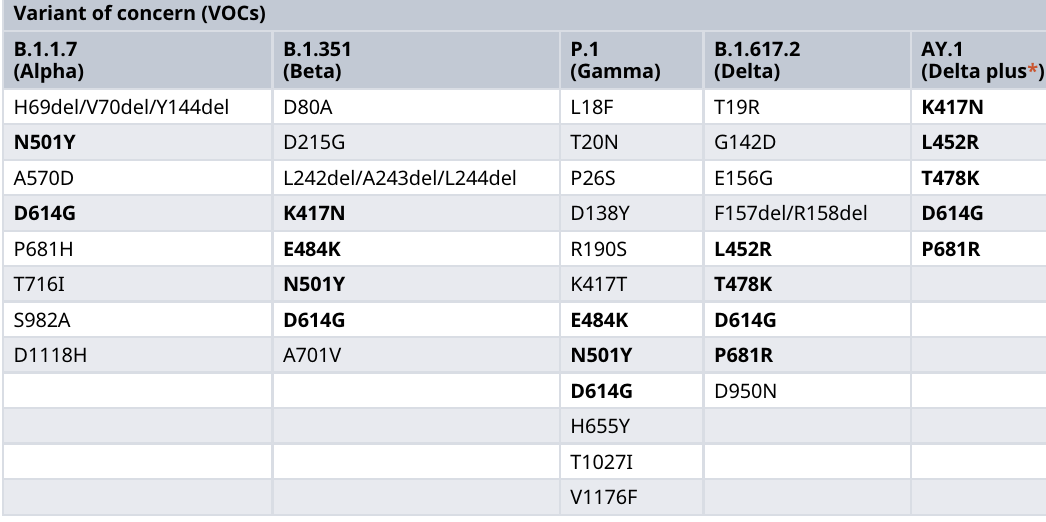
Table 1. Spike mutations reported in variants of concern VOCs. Mutations in bold represent its presence in different variants. Variant of concern